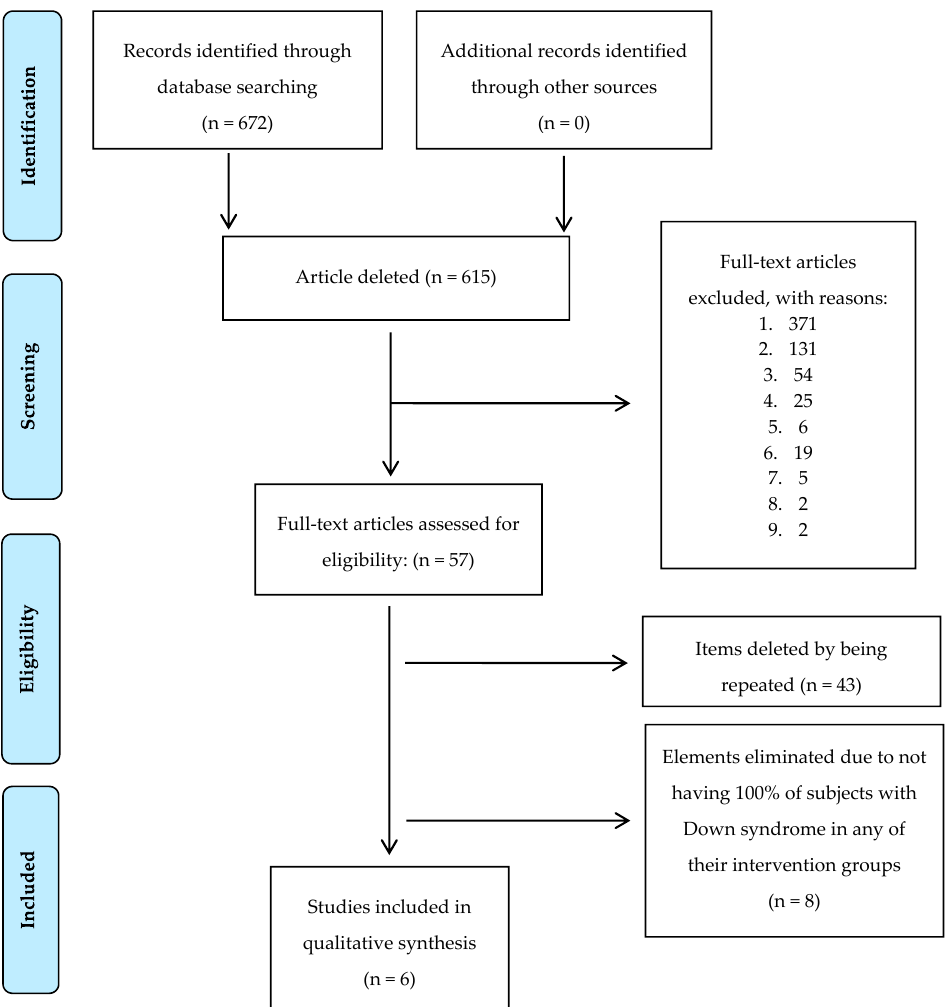
Figure 1. Flow chart in the screening process for the selection of included clinical trials [18]. Legend exclusion criteria: 1. Subjects not related to the variation of body composition in patients with excess weight; 2. Other intellectual or developmental disabilities that do not include Down syndrome; 3. Reviews and / or meta-analysis; 4. Interest in other pathologies (diabetes, hypertension,